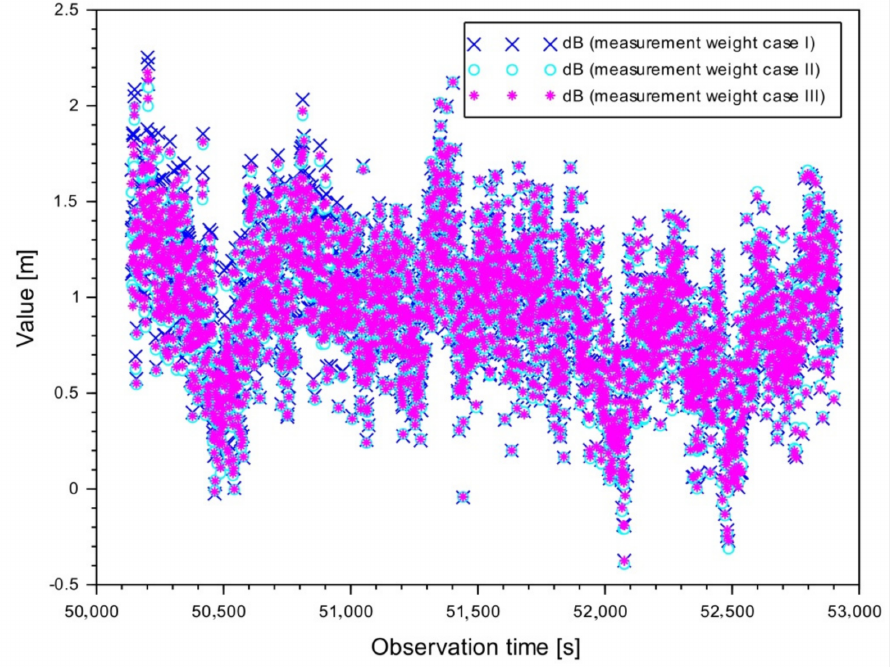
Figure 13. Results of position errors dB